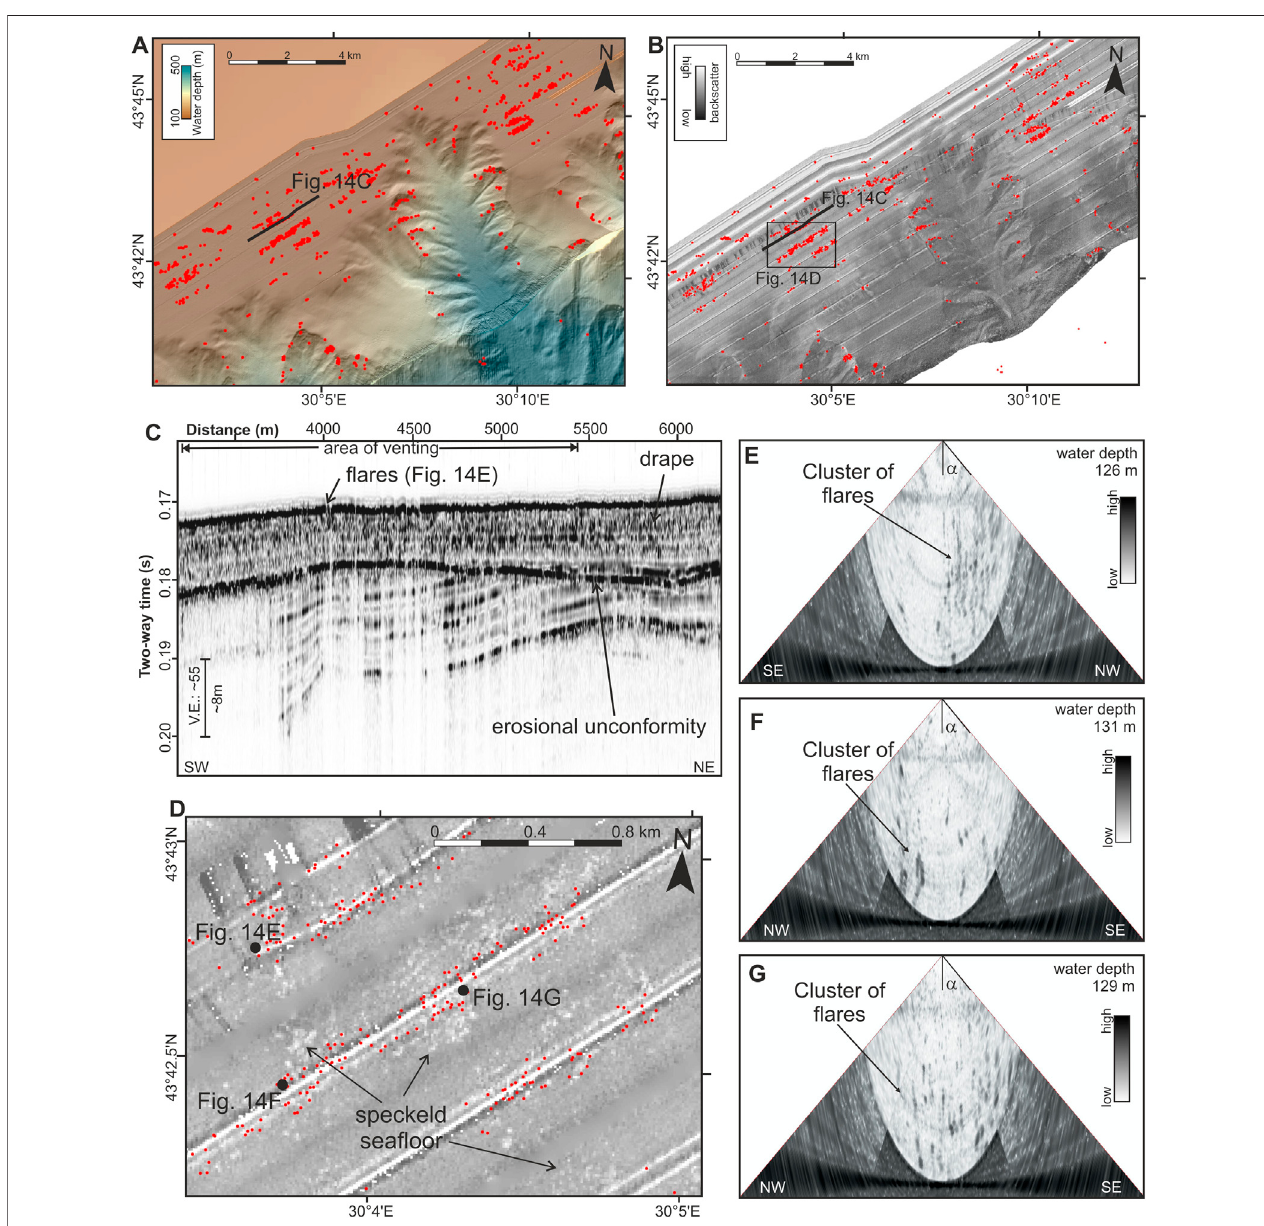
FIGURE 14 | Examples of gas vent occurrences (red dots) along the western portion of the shelf region in our study area. Shown are (A) water depth, and (B) sea fl oor backscatter near the S1 channel head. (C) The sub-pro fi ler data reveal a drape of post-glacial sediments ( ∼ 10 m thick) above an erosional unconformity. Here, the gas fl ares are occurring in dense clusters that also can be seen in the backscatter data as high-amplitude patches, described as speckled sea fl oor (D) . (E – G) are examples of EM710 multibeam data showing abundant gas fl ares in the water column above the speckled sea fl oor.